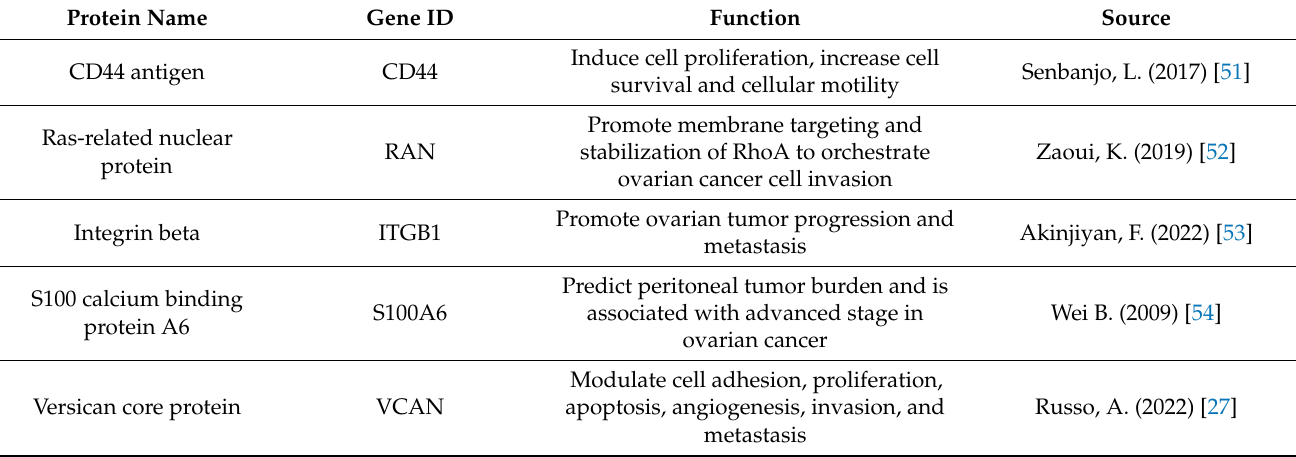
Table 2. The list of proteins among the 295 identified human fallopian tube epithelial (hFTE) sEV proteins with known functions in cancer progression and